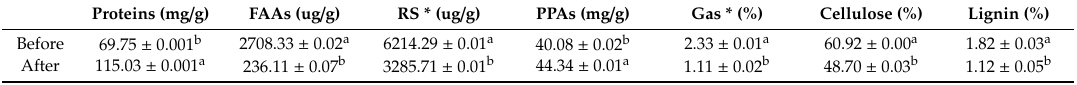
Table 7. The main components in the G. biloba leaves before and after